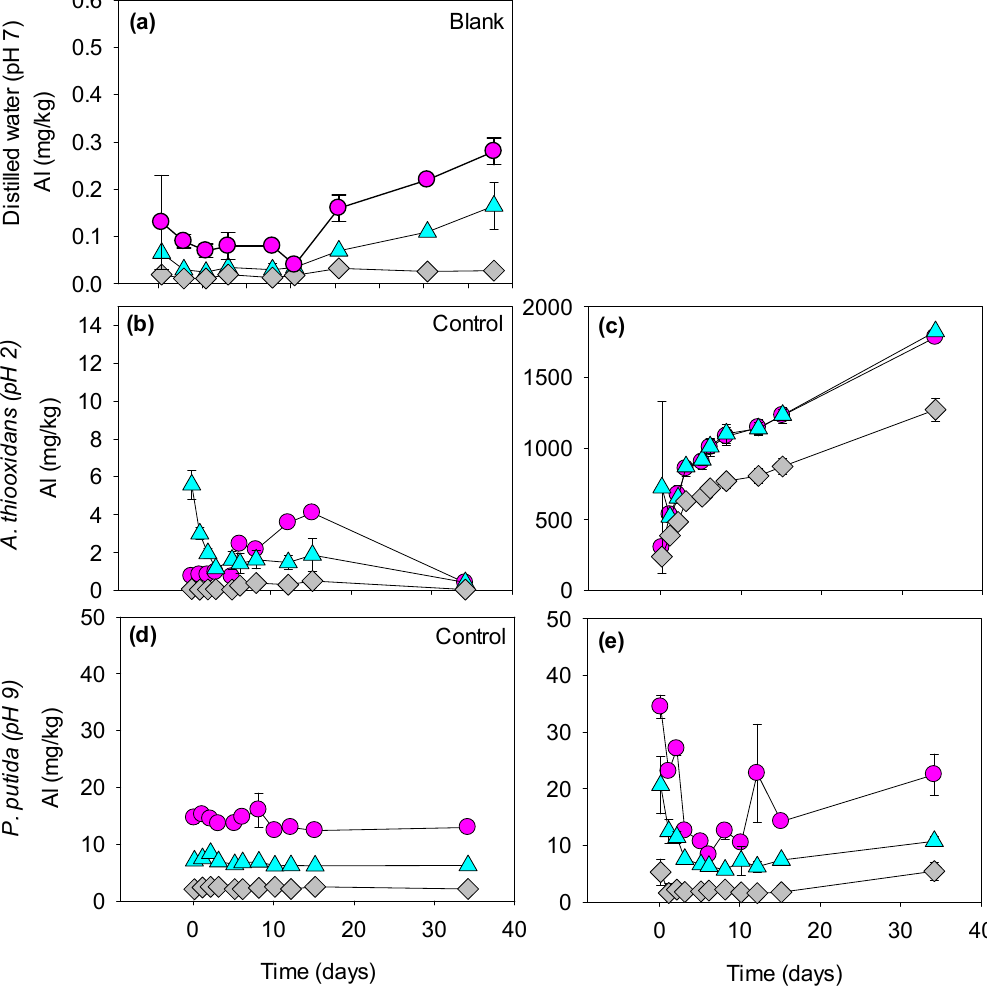
Figure 8. Al concentrations in the leachate as a function of time during (bio)leaching experiments of the fresh tailing sample with distilled water ( a ), incubated with A. thiooxidans ( c ) and P. putida ( e ). Controls for A. thiooxidans and P. putida are displayed in ( b , d ), respectively. Three pulp densities were evaluated: 5 g/L ( ), 10 g/L ( ), and 30 g/L ( ).